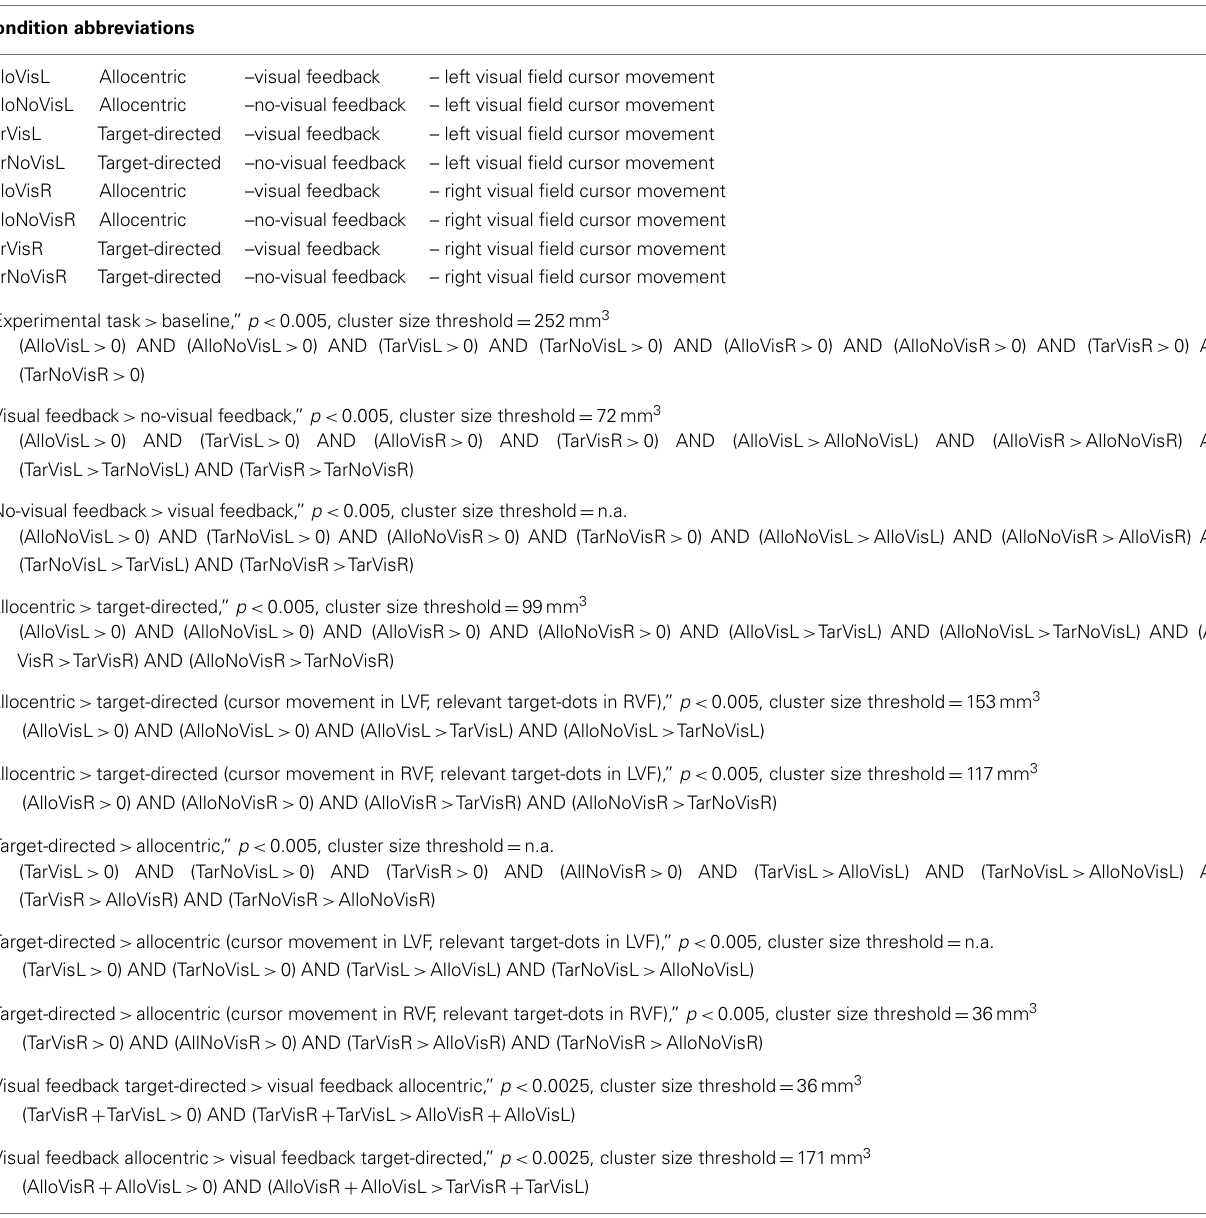
Table 1 | Names, p -values, and syntax of conjunctions used for statistical analysis of functional fMRI